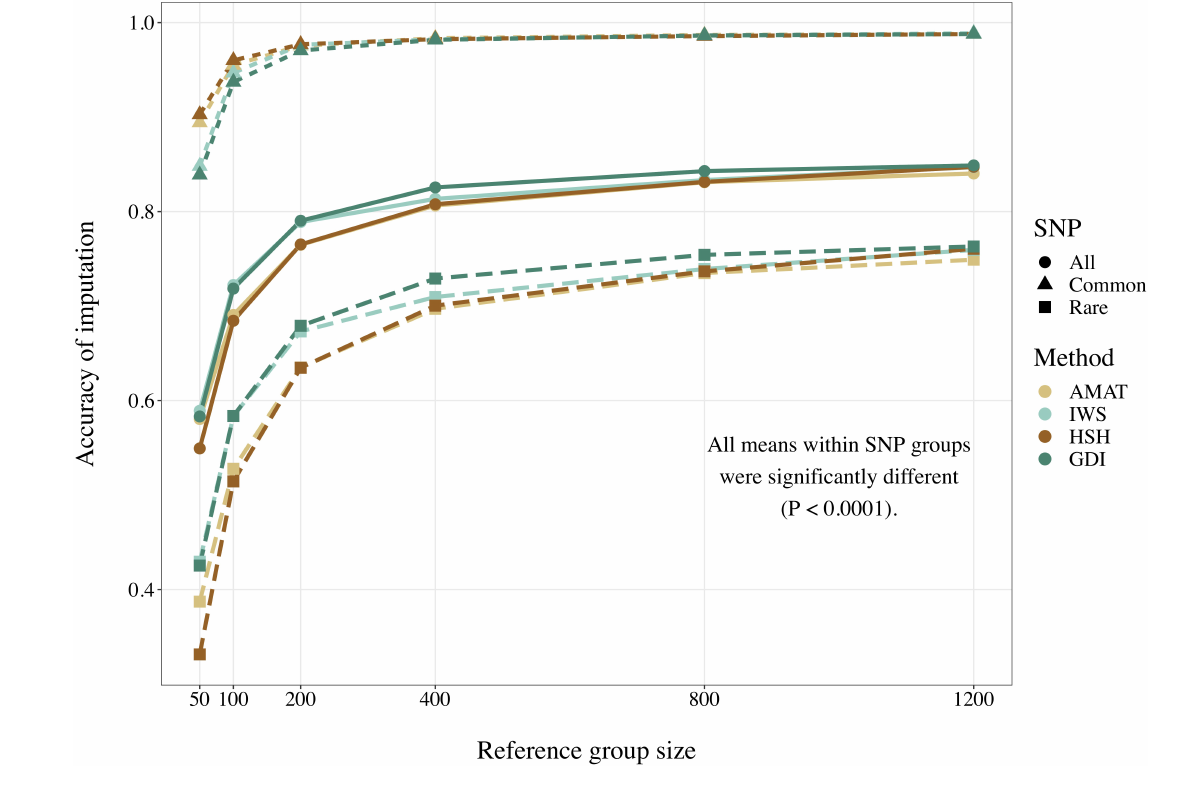
Frontiers in Genetics |